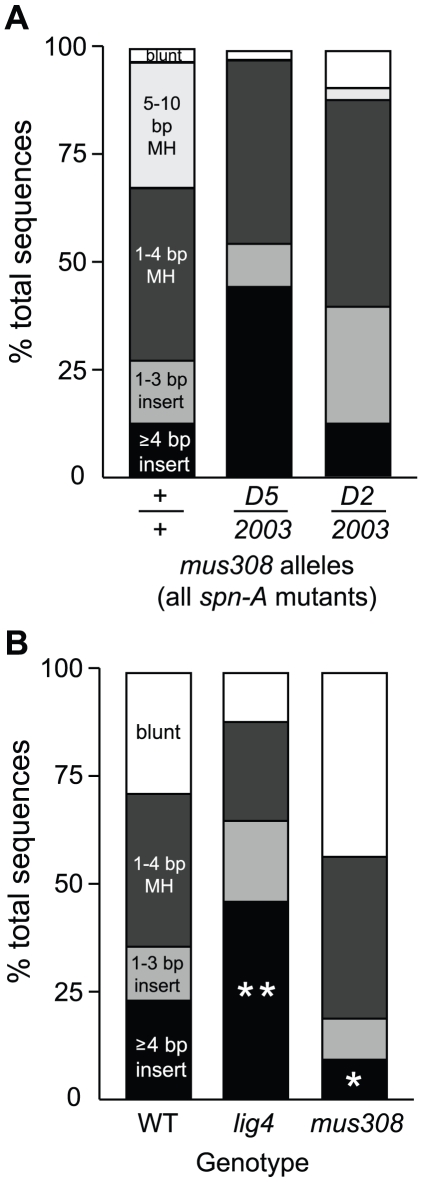
Pol θ is required for two distinct classes of alt–EJ repair products.(A) Annealing at long microhomologies is greatly decreased in pol θ mutants. Repair junctions isolated following P(wa} excision were amplified from spn-A and spn-A mus308 females of the indicated genotypes and sequences were aligned to the original P(wa} chromosome. White, blunt joins; hatched, 5–10 bp microhomologies; light gray, 1–4 bp microhomologies; dark gray, 1–3 bp insertions; black, ≥4 bp insertions. Number of junctions sequenced: spn-A = 68, spn-A093mus308D5/spn-A057mus3082003 = 23, spn-A057mus308D2/spn-A057mus3082003 = 25. The percentage of 5–10 bp microhomologies was significantly decreased in both spn-A mus308 mutants (P<0.01, Fisher's exact test). (B) Reduced frequency of ≥4 bp insertions during inaccurate end-joining repair of a chromosomal I-SceI DSB in mus308 mutants. Complementary ended DSBs were induced by expression of I-SceI endonuclease in the pre-meiotic germline of wild type (n = 70), lig4169a (n = 83), and mus3082003/Df(3R)kar-Sz29 (n = 57) males, and independent inaccurate end-joining repair junctions were sequenced. White, blunt joins; light gray, 1–4 bp microhomologies; dark gray, 1–3 bp insertions; black, ≥4 bp insertions. No >4 bp microhomologies are available near the DSB in this system. * indicates P = 0.03, ** indicates P<0.01, relative to wild type (Fisher's exact test).